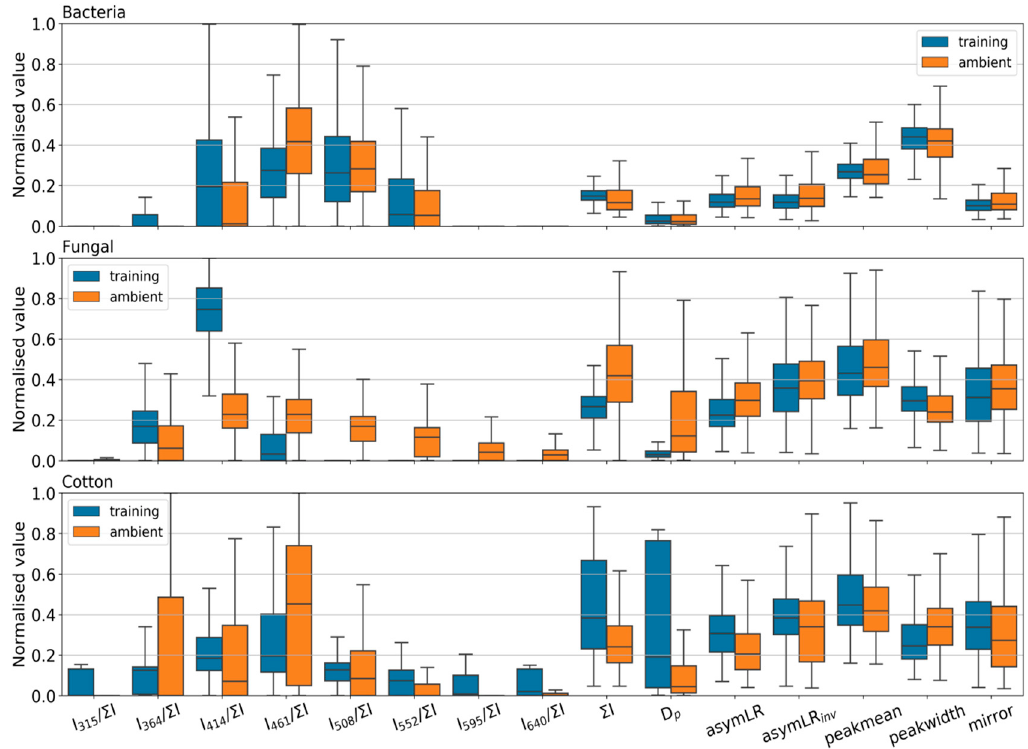
Figure 6. Comparison of training (blue) and ambient (orange) parameter distributions for each class. Top: Bacteria-like; Middle: fungal-like; Bottom: Cotton-like. Fluorescent spectra have been normalised by the total fluorescent intensity. All other parameters have been scaled to the maximum possible expected value. Whiskers denote 5th and 95th percentiles.